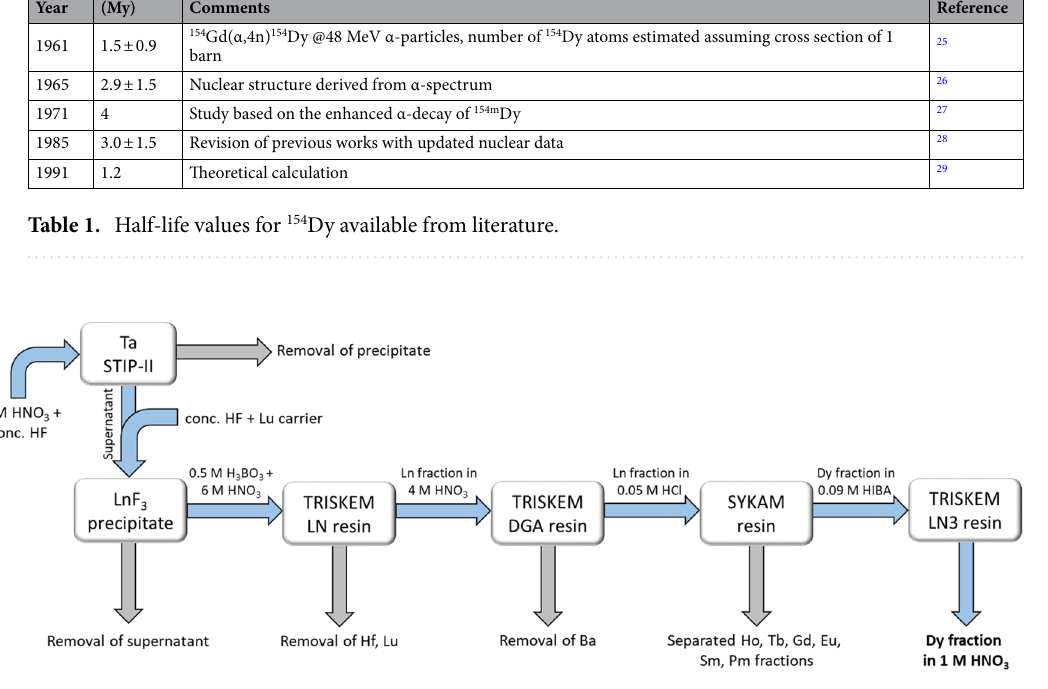
Figure 1. Separation scheme adopted for the retrieval of a pure Dy fraction (in 1 M HNO 3 ) containing the exotic radio-lanthanide 154 Dy. The so-obtained Dy fraction is suitable for mass spectrometric analysis without further processing. The scheme was made with the Microsoft PowerPoint 2016